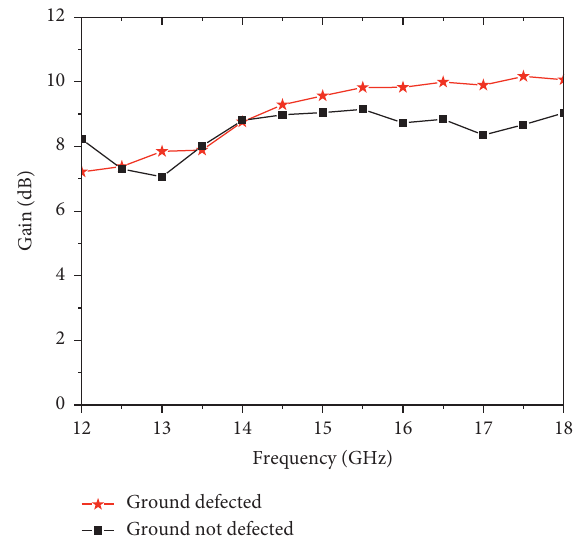
Figure 7: Effect of the defect ground plane on the proposed design.